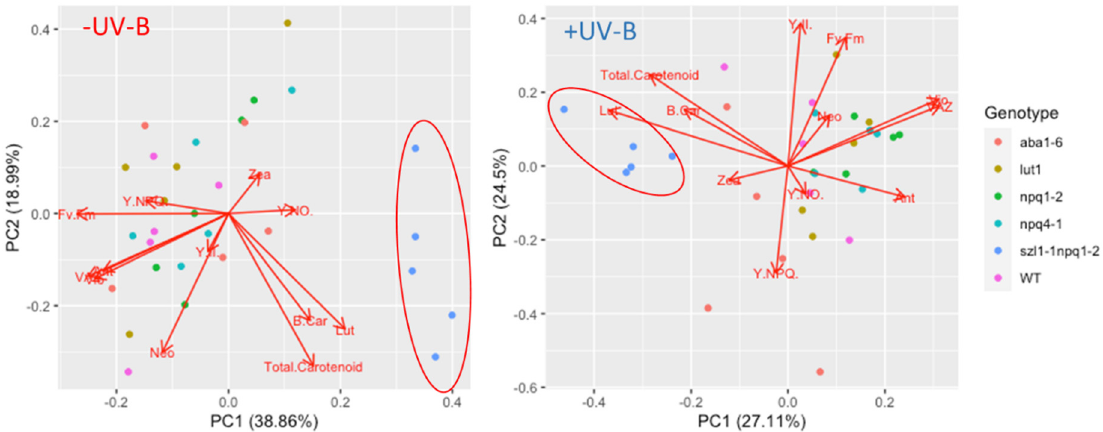
Figure 7. Principal component analysis showing the distribution of UV treated and/or control carotenoid impaired Arabidopsis genotypes (score plot), based on the influence of carotenoids and photosynthetic efficiency parameters (loading plot).